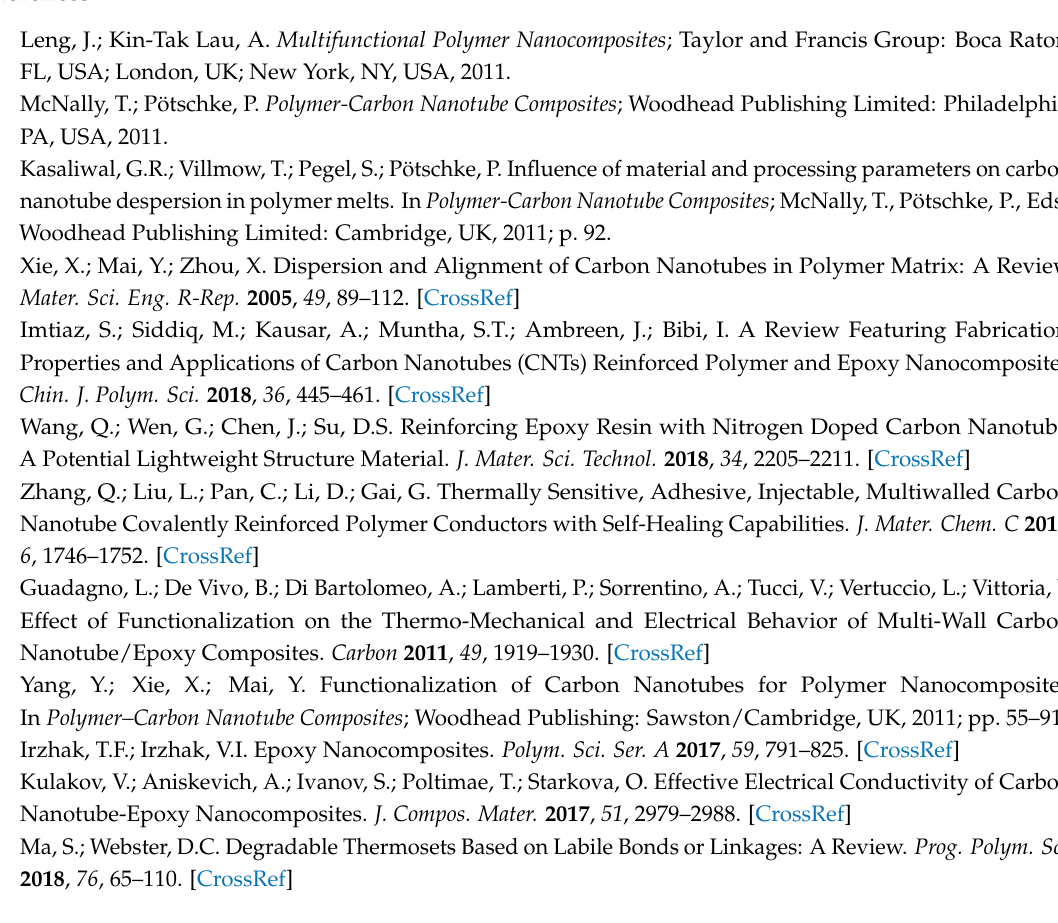
s1, Table S1: Synthesis of PK-Fu and PK-Bea, Table S2: Calculation of grafted MWCNTs with PK-Fu, PK-Bea and bis-maleimide, Figure S3: Raman spectra of pristine and PK-Fu, B-Ma, PK-Bea functionalized MWCNTs, Figure S4: SEM micrographs of (A) pristine MWCNTs and (B) PK-Fu functionalized MWCNTs, Figure S5: DSC thermal cycles of crosslinked PK-Fu with B-Ma, Figure S6: ATR-FTIR spectra of PK-Fu crosslinked with B-Ma and reinforced with MWCNTs, Figure S7: Statistical analysis of PK-Fu/B-Ma/MWCNT